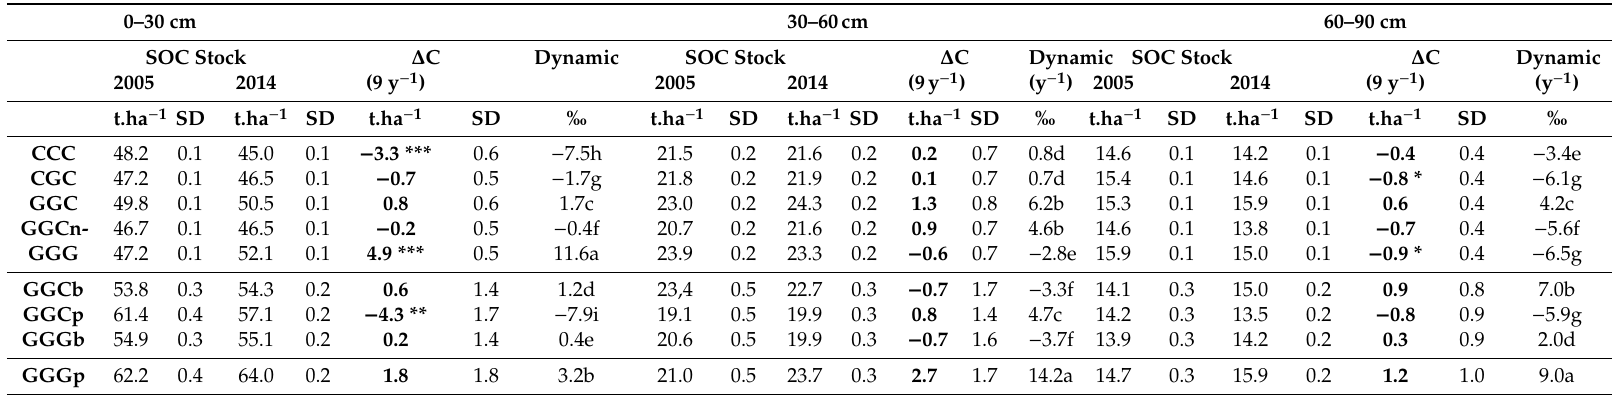
Table 3. Predicted carbon stocks and their evolution under di ff erent grassland management. SD is standard deviation, * is statistical significances of storage’s Z-score (shown in Figure 3, * p -value is < 0.05, ** p -value is < 0.01 and *** p -value is < 0.001) and a lowercase letter is statistical significance from ANOVA and Tukey’s HSD post-hoc test. Total stock changes over 9 years ( ∆ C) are printed in